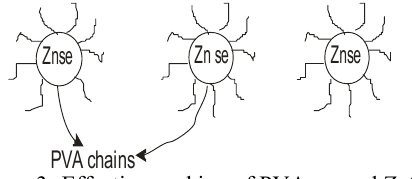
Figure 3 : Effective packing of PVA around ZnSe nanoparticles